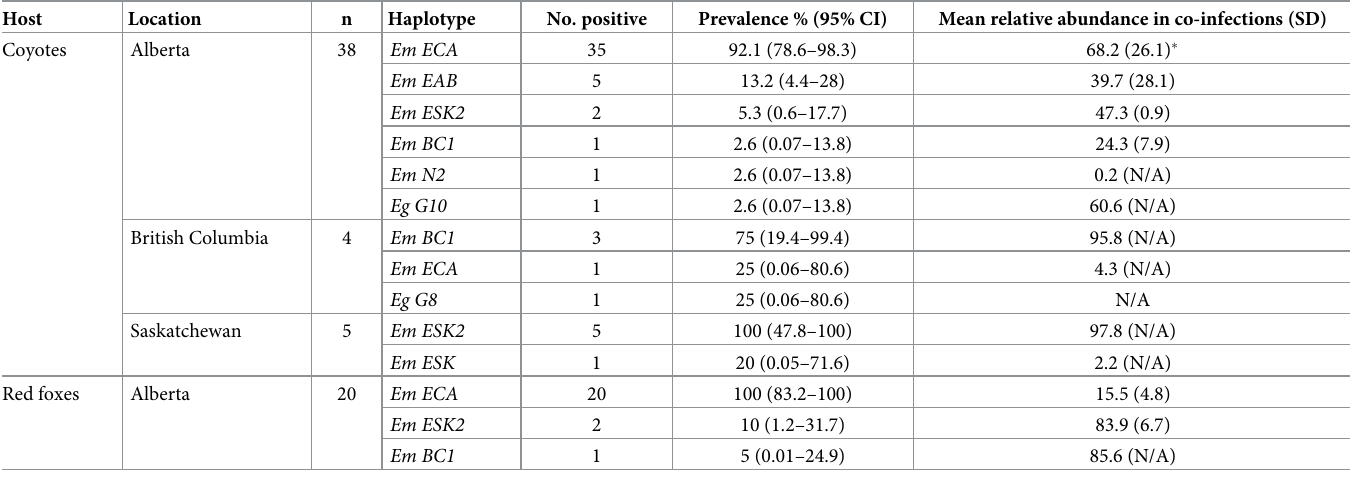
Table 2. Prevalence and mean relative abundance of E . multilocularis and E . granulosus s . l . haplotypes found in western